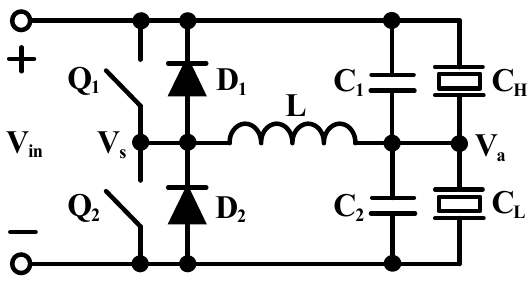
Figure 20. Switching amplifier driver with LC.